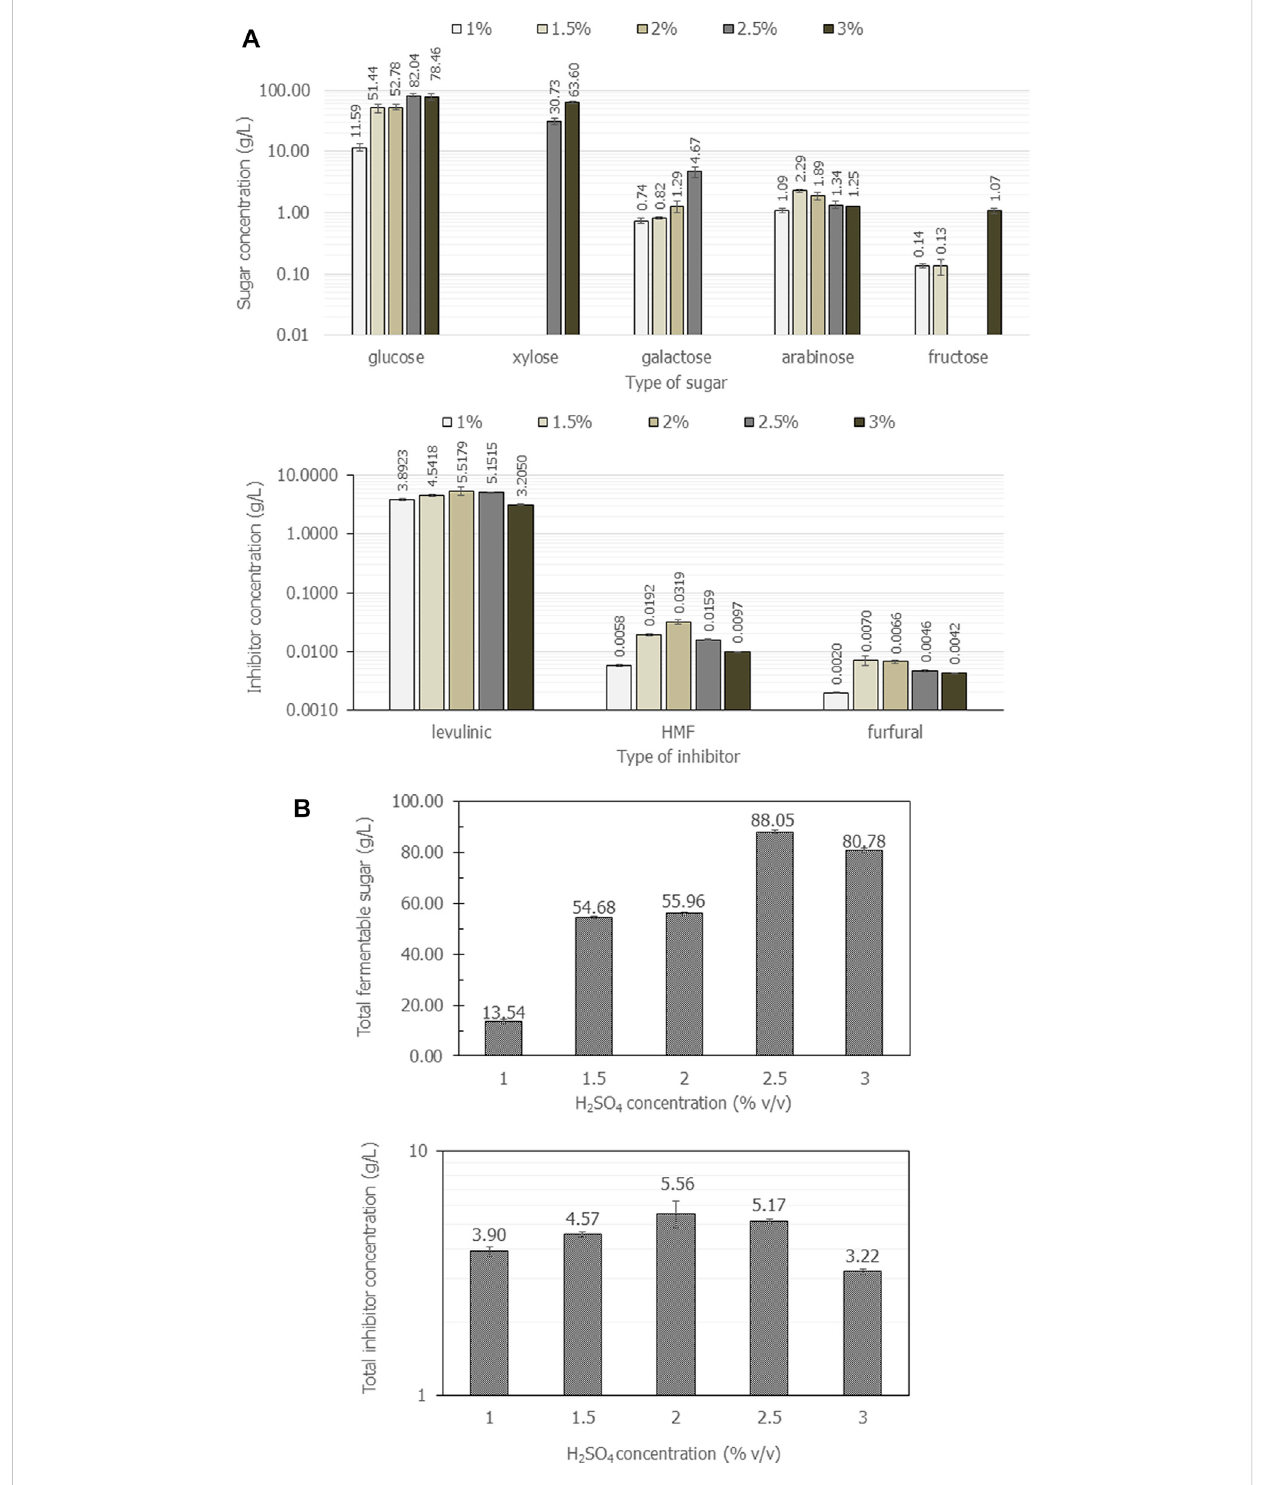
FIGURE 2 The composition of fermentable sugars and inhibitors (A) and total amount of fermentable sugars and inhibitors (B) when cassava pulp was hydrolyzedwithliquid-to-solidratiosof20 mL/gusing1%,1.5%,2%,2.5%,and4%(v/v)H 2 SO 4 undermicrowaveirradiationat800 Wfordifferenttimesfor 3, 5 and 8 min. All the data are representative of the results of three independent experiments and are expressed as the mean values ± standard deviations